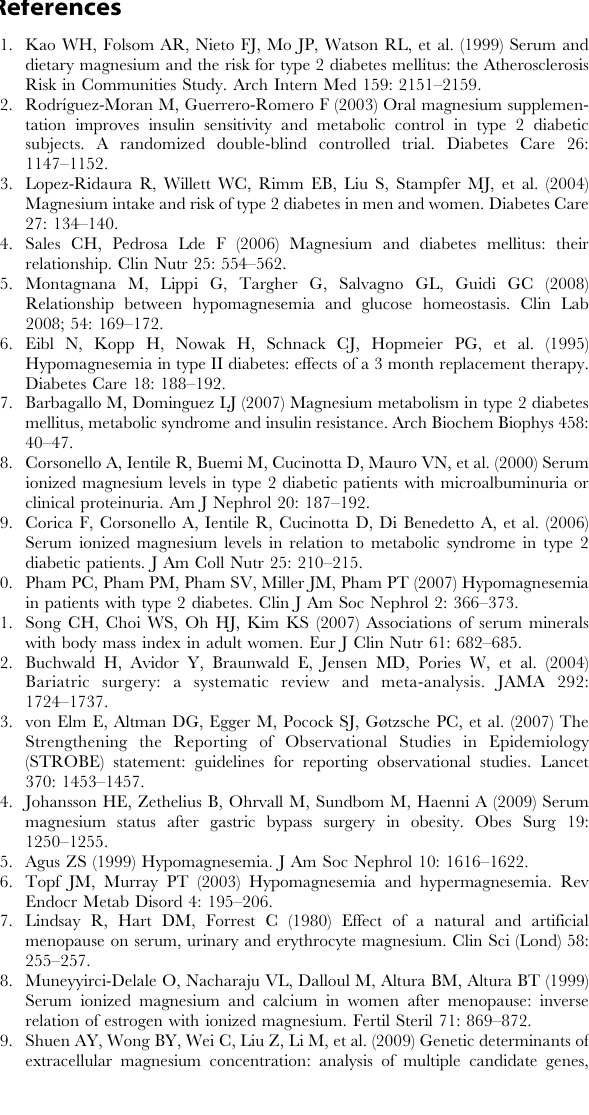
Table S2 Multiple linear regression analysis to explore variables months in subjects who underwent